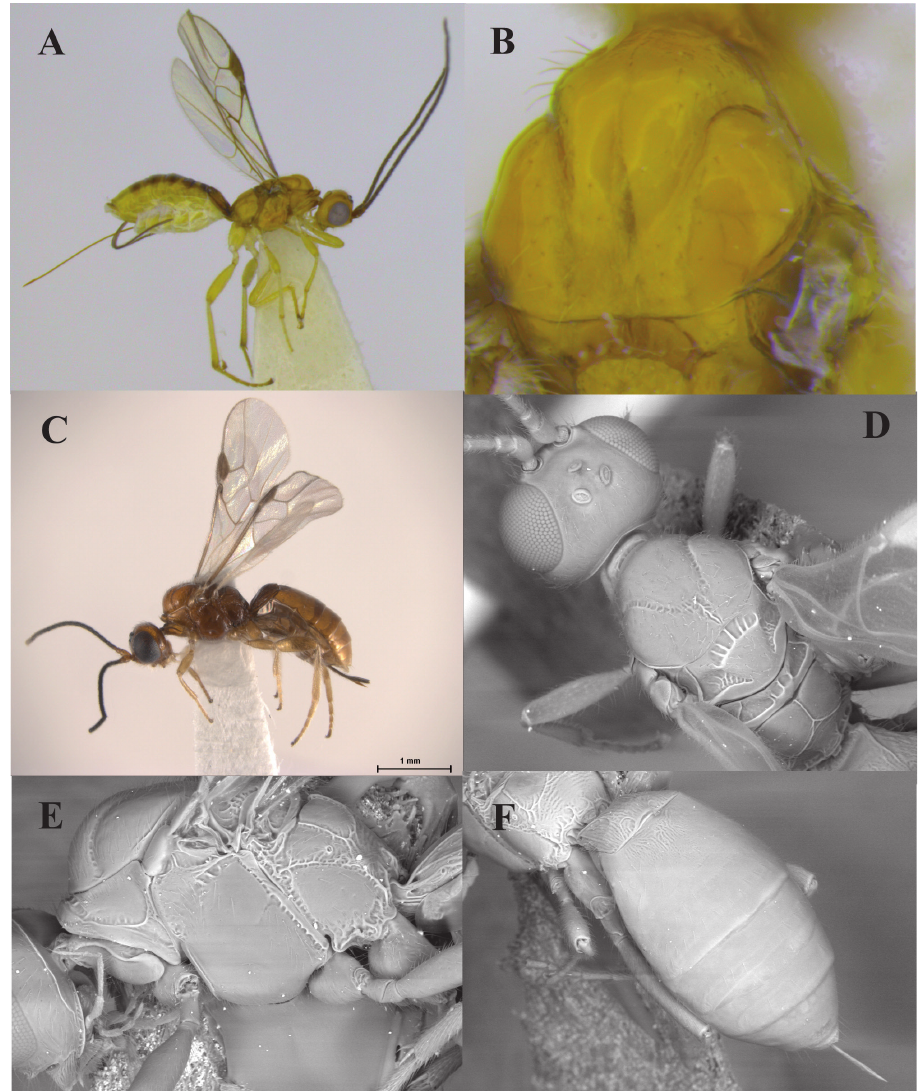
Figure 5. Lissopsius flavus Marsh: A habitus, lateral view B mesoscutum, dorsal view. Lissopsius pacificus sp. n. (holotype): C habitus, lateral view D head and mesosoma, dorsal view e mesosoma, lateral view F metasoma, dorsal